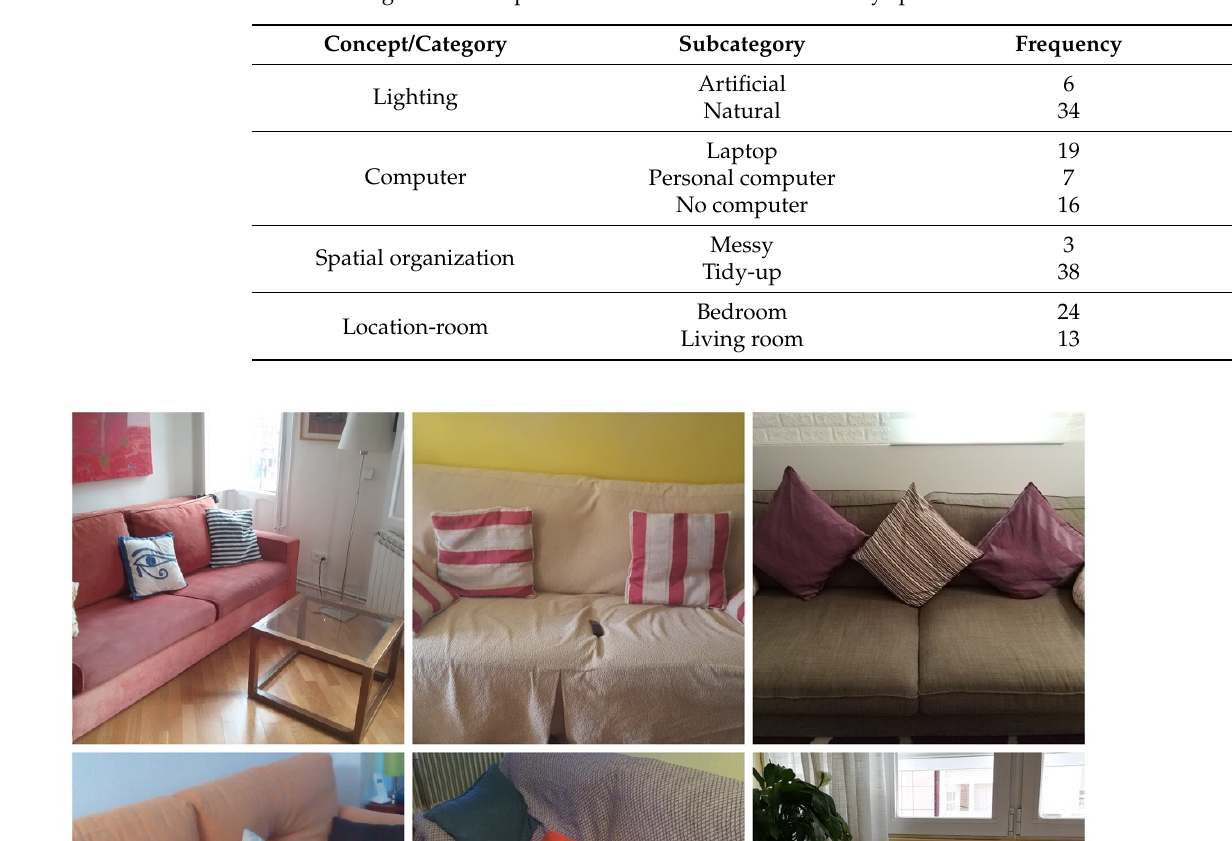
Table 1. Categorization of pictures’ content related to tele-study spaces.